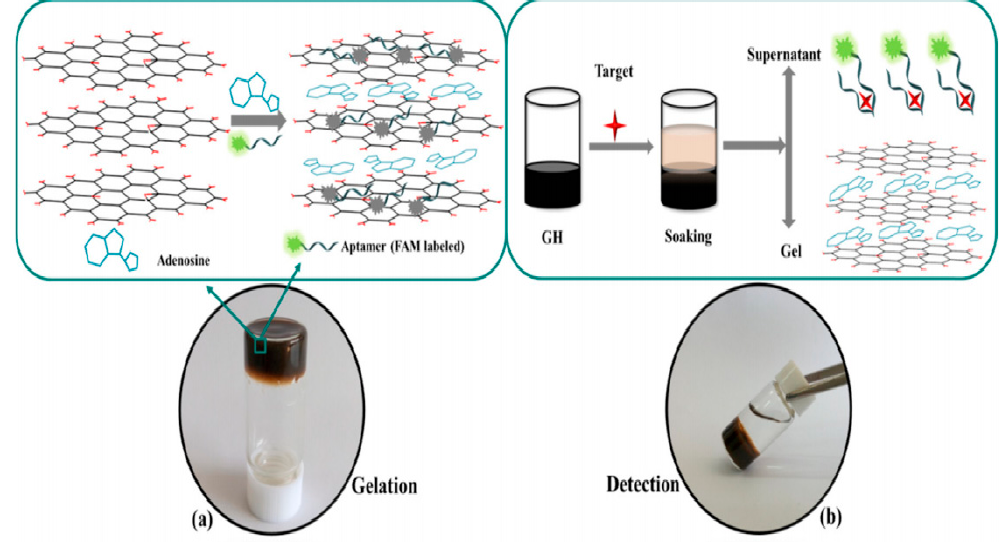
Figure 5. Fabrication of 3D macroscopic hydrogel with graphene oxide nanosheets ( a ) and the mechanism of selective detection of antibiotics ( b ). Reprinted with permission from reference [92] .